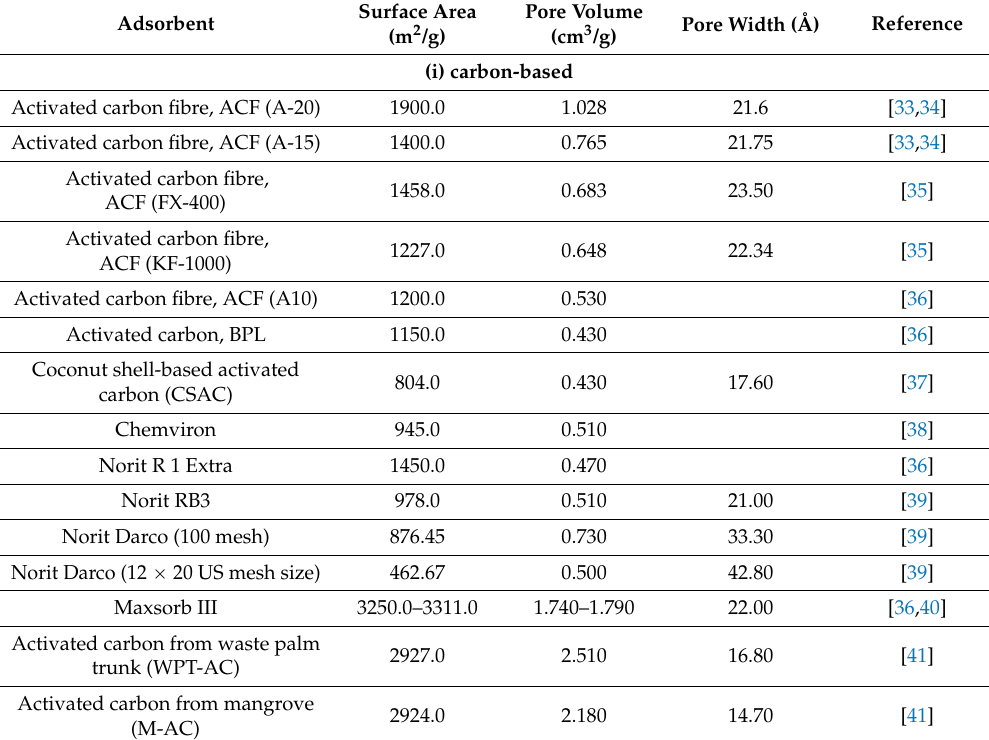
Table 3. Commonly-used adsorbents along with their porous